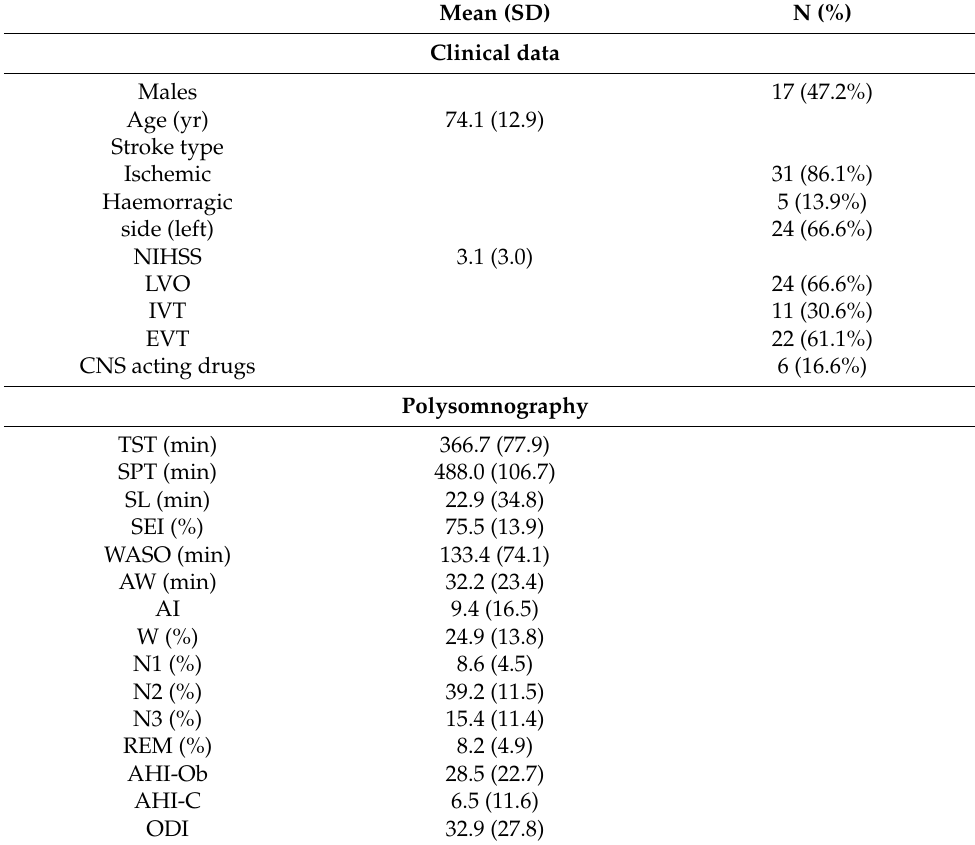
Table 2. Demographic, clinical and polysomnographic characteristics of the study cohort. LVO, large vessel occlusion; IVT, intravenous thrombolysis; EVT, endovascular treatment; CNS, central nervous system; TST, total sleep time; SPT, sleep period time; SL, sleep latency; SEI, sleep efficiency index; WASO, wake after sleep onset; AW, mean duration of awakenings lasting more than two minutes; AI, arousal index; W, percentage of wake on sleep period time; N1, percentage of N1 stage on sleep period time; N2, percentage of N2 stage on sleep period time; N3, percentage of N3 stage on sleep period time; REM, percentage of REM stage on sleep period time; AHI-Ob, apnea-ipopnea index obstructive; AHI-C, apnea-ipopnea index central; ODI, oxygen desaturation